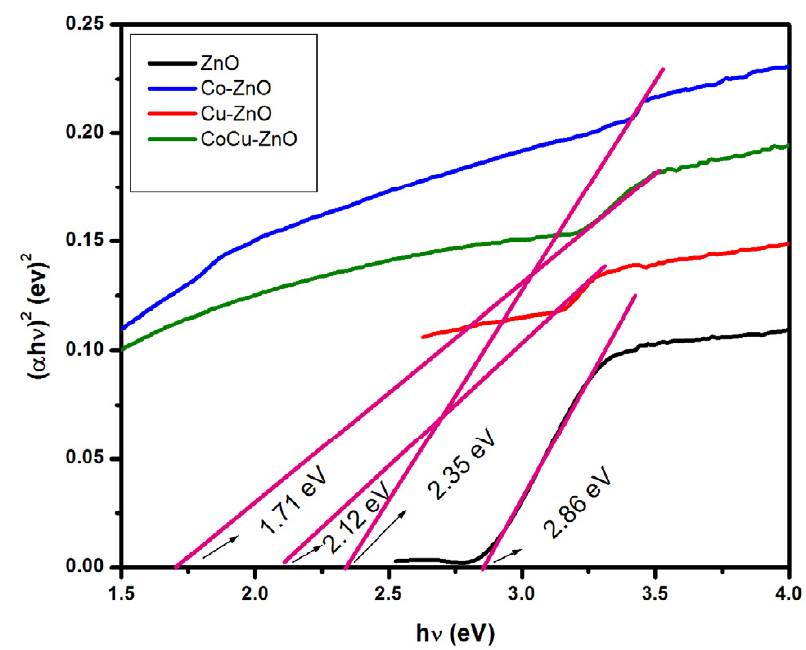
Fig. 2. Tauc plot of ZnO,Co-ZnO, Cu-ZnO and (d) CoCu-ZnO